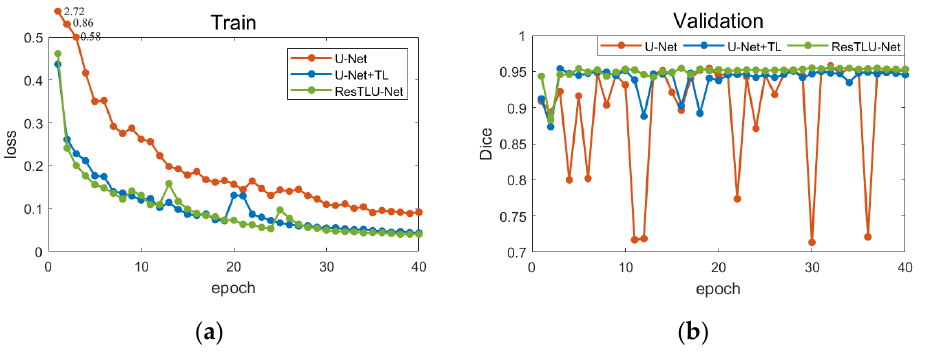
Figure 9. Line chart of loss value and validation result in network training. ( a ) Loss in the training process of different networks; ( b ) Dice coefficients on the validation set.